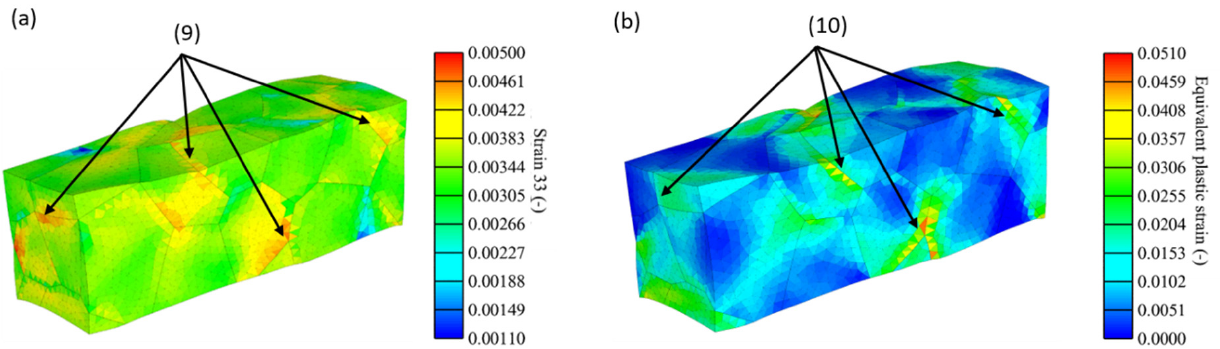
Figure 8. ( a ) Strain S33 and ( b ) equivalent plastic strain in loading direction for the stiff orientated specimen.